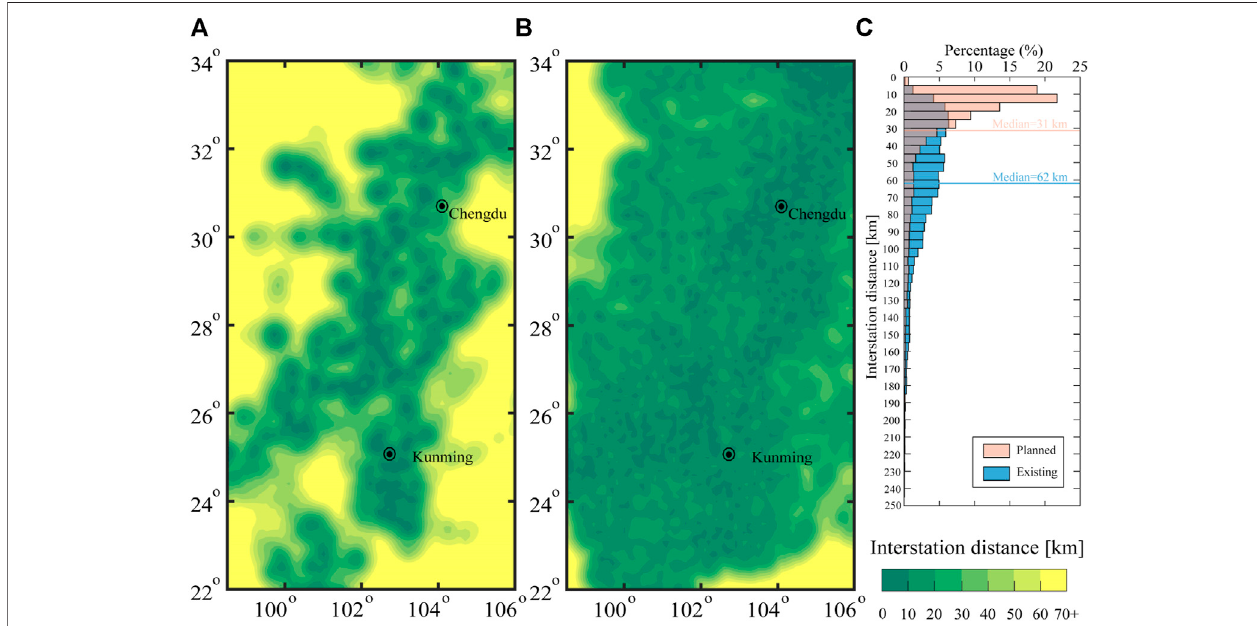
FIGURE2| Mapsshowingtheinterstationdistancesforthe (A) existing,and (B) plannednetworkshownin Figure1 .Areascoloredindarkgreenhavethedensest stationcoverage.Foranygivensite(computedonagridof0.1 × 0.1resolution),theinterstationdistanceiscalculatedastheaveragedistancetothethreeclosestseismic stations.InordertocomparewithnetworksinJapan,CaliforniaandBeijingCapitalRegion,weapplythesamecolorscalerangeasinKuyukandAllen(2013)andLietal. (2016). The histogram in (C) shows the variability in the interstation distances across the Sichuan-Yunnan region. The interstation distance is currently around 60 km for half of the study region and will be reduced to around 30 km for three quarters of the whole region by 2022.